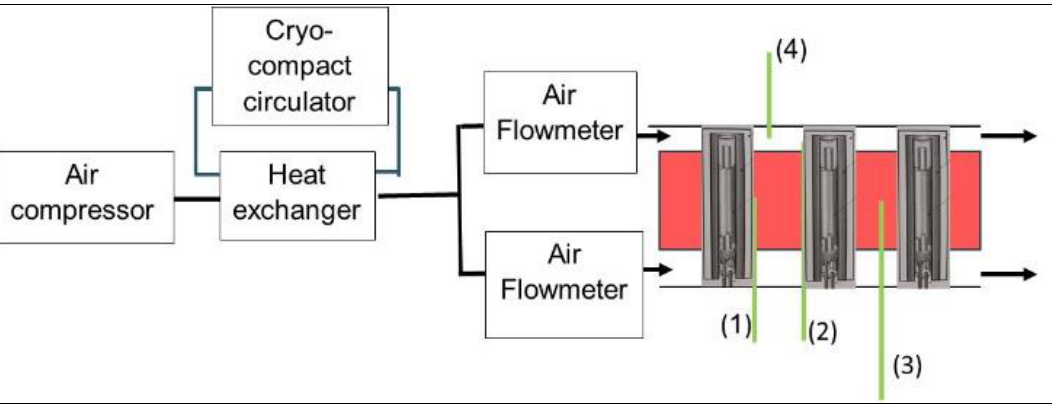
Figure 9. A schematic of the test setup.